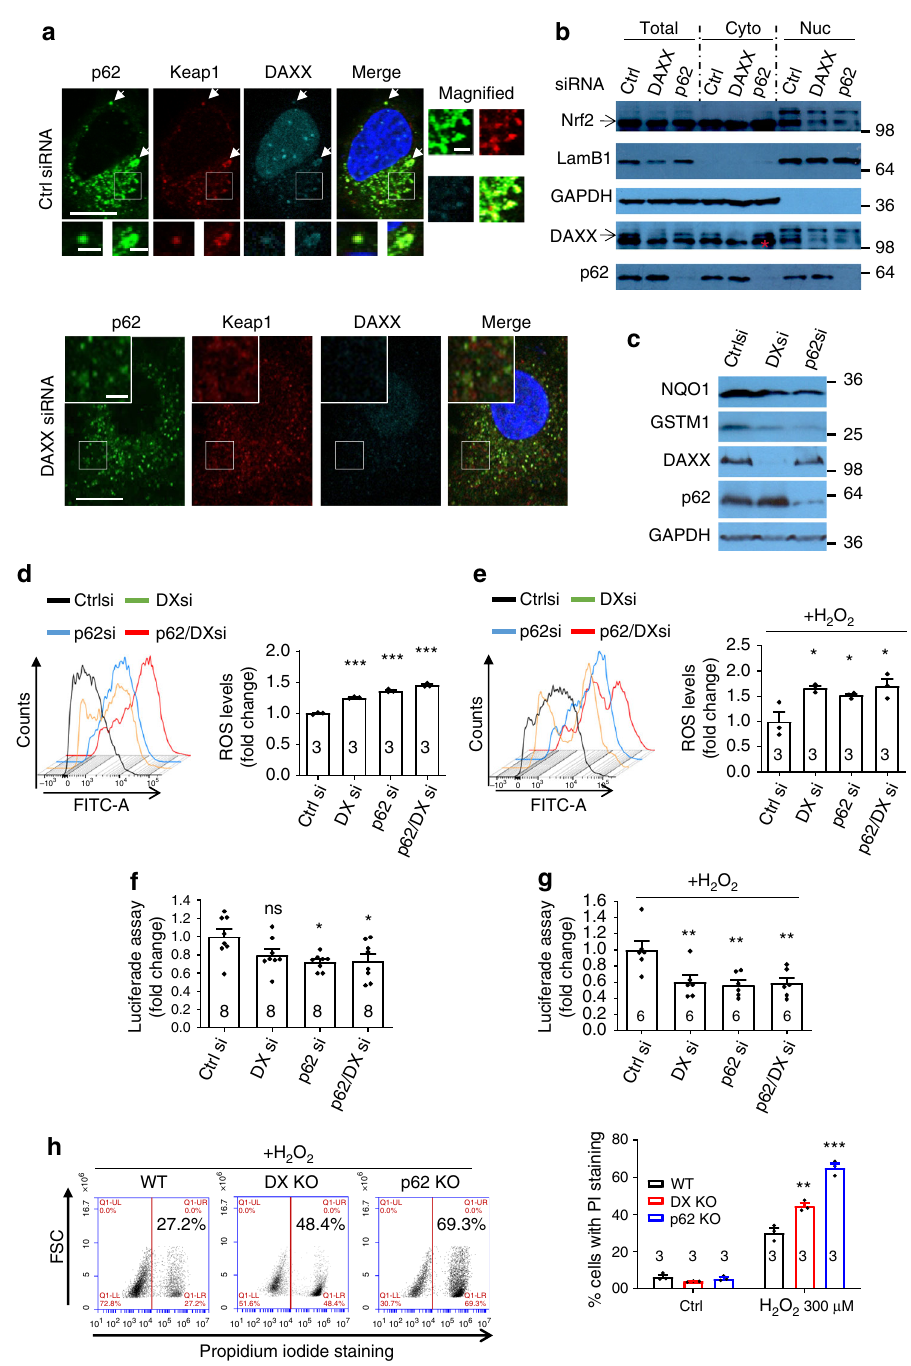
Yeast two-hybrid screening . Clontech Matchmaker Gold Yeast Two-Hybrid System was used for our yeast two-hybrid (Y2H) screening. Brie fl y, p62 1-300aa as a bait was cloned into pGBKT7. The bait cDNA was transformed into Y2HGold (the yeast strain). cDNA expression was con fi rmed by in vitro translation. The yeast Y187 harbouring human cDNA library (Mate & Plate Human Heart Library, #630417) was mated with Y2HGold with p62 1-300aa. Following the mating, four reporters detect protein – protein interactions, namely Aureobasidin A (Aba) resistance, histidine (His) minus resistance, adenine (Ade) minus resistance and blue colour with X-alpha-Gal. In addition, pGBKT7 plasmid confers leucine (Leu) minus resistance and pGADT7 confers tryptone (Trp) minus resistance. Therefore, media with Leu-, Trp- and/or His-, Ade- along with Aba resistance and blue colour were used to select positive yeast clones. Plasmids were isolated from the